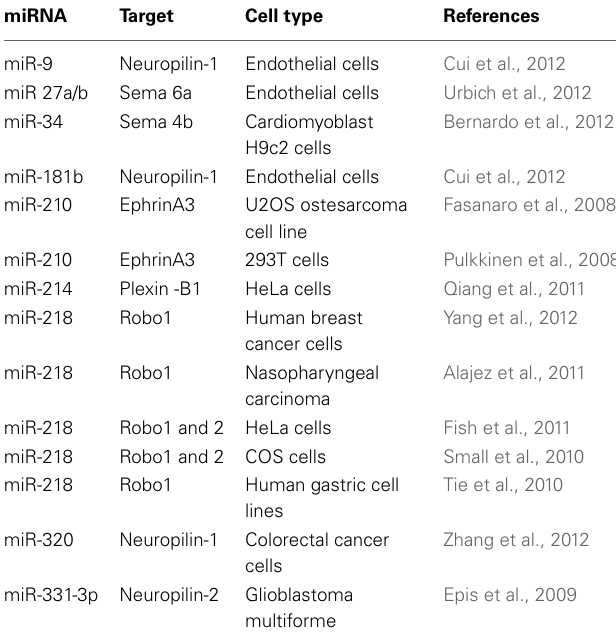
Table 4 | List of miRNAs regulating guidance molecules in non-neuronal